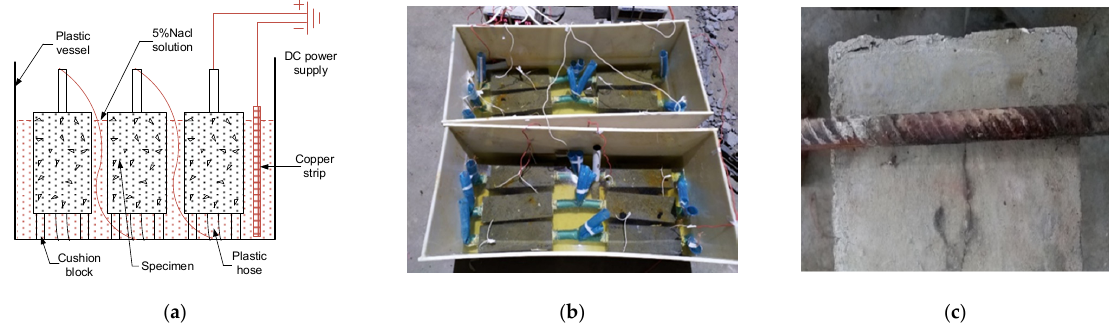
Figure 5. Corrosion method: ( a ) The corrosion system with constant current in laboratory. Adapted with permission from [29]; ( b ) Field experiment; ( c ) Stirrup corrosion.